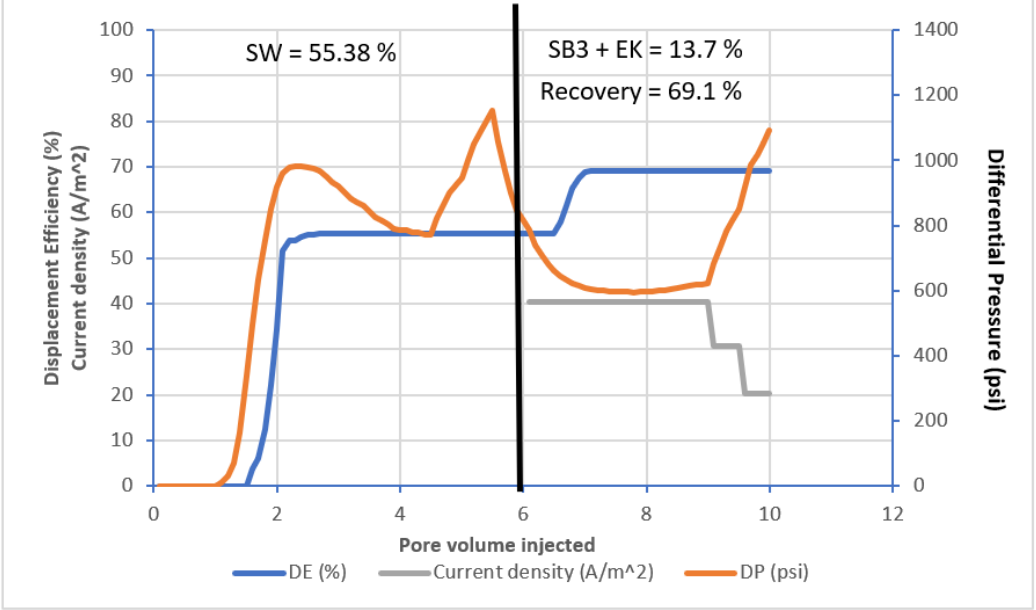
Figure 8. DE, DP (ΔP), Current Density vs. Pore Volume Injected for CF6 . Figure 8. DE, DP ( ∆ P), Current Density vs. Pore Volume Injected for CF6.